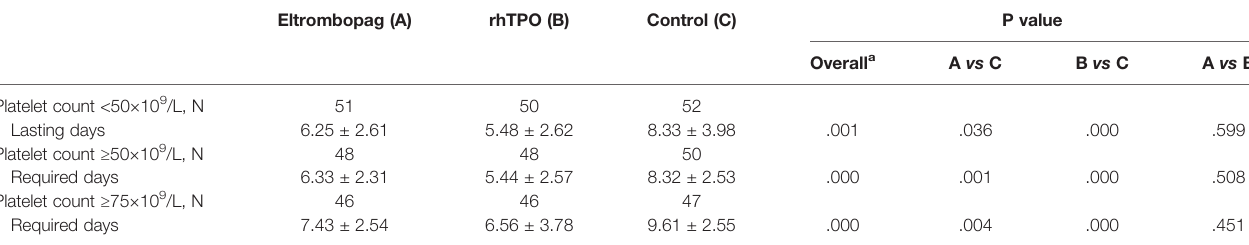
TABLE 3 | Platelet response among the three